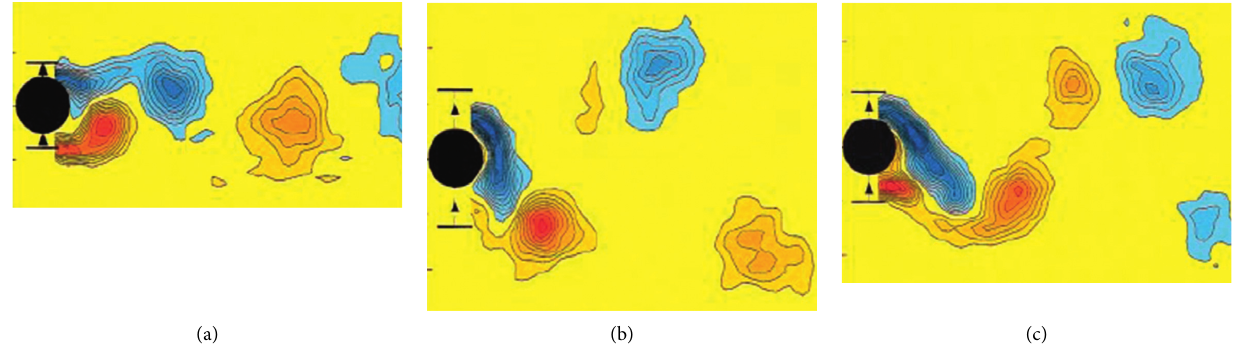
Figure 10: Vortex patterns of the three VIV response branches, from Govardhan and Williamson [28]. (a) Initial branch. (b)Upper branch. (c)Lower